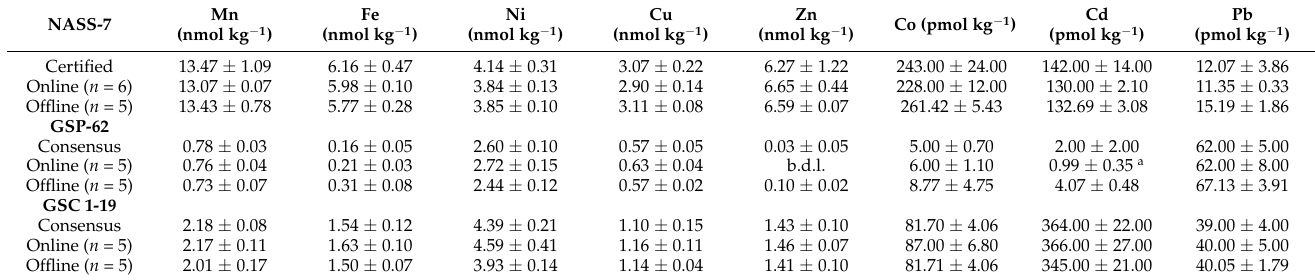
Table 5. Results of seawater reference materials compared to consensus